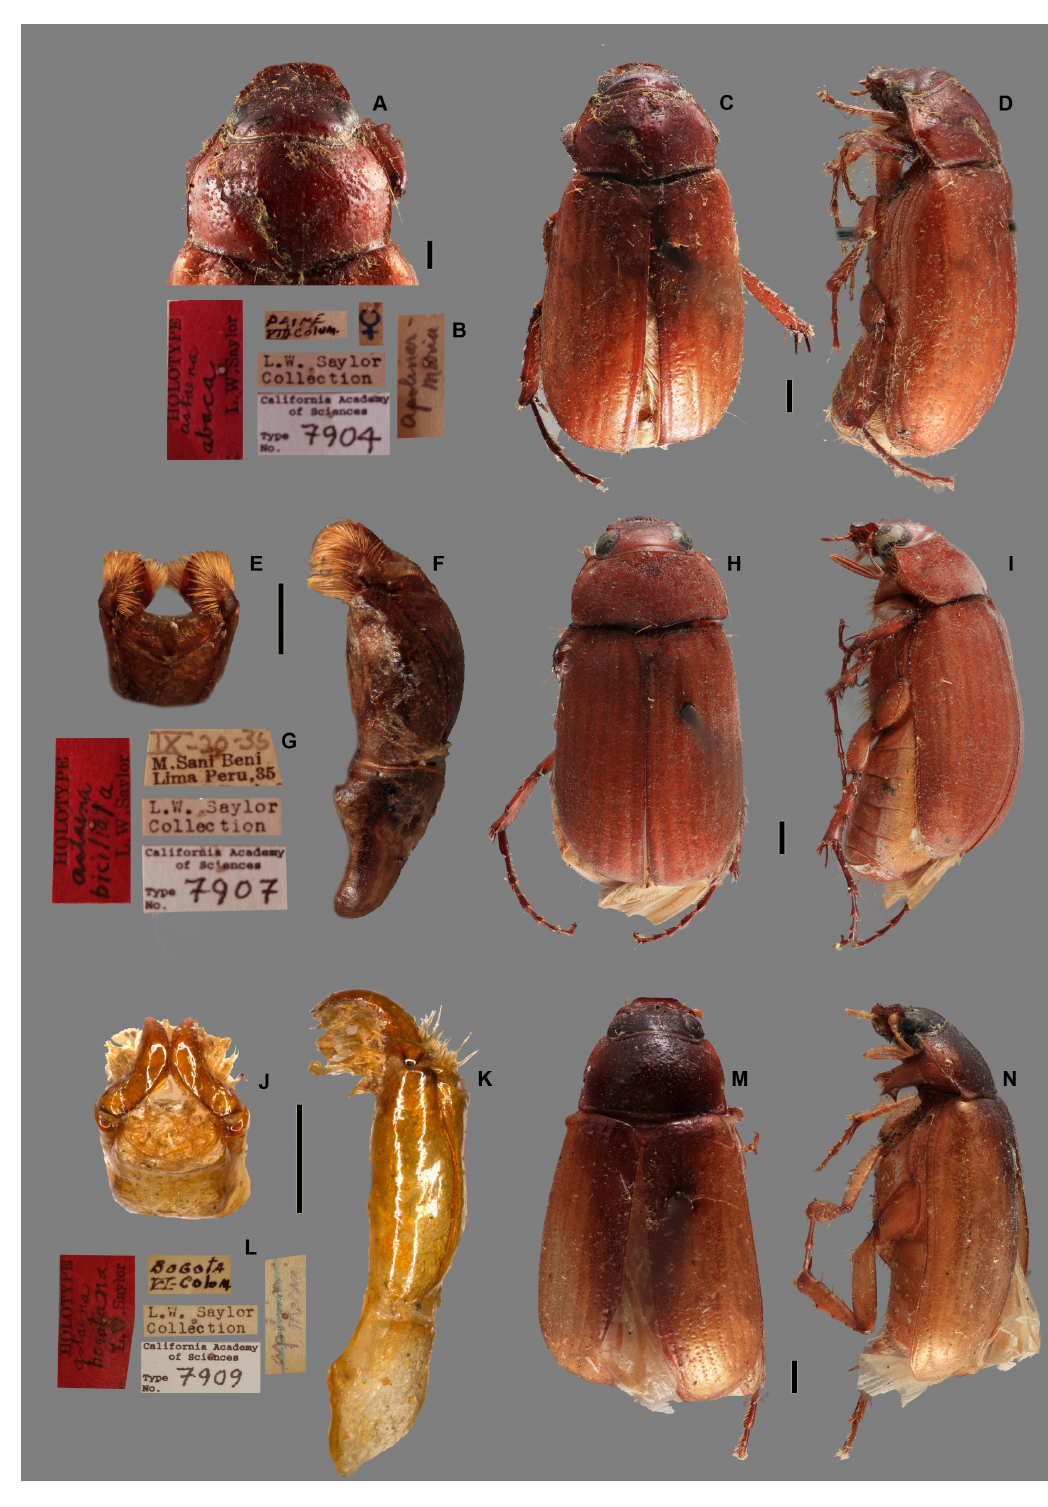
Fig. 1. A–D . Astaena abaca Saylor, 1946, holotype, ♀ (Type No. 7904; CAS). – E–I . A. biciliata Saylor, 1946, holotype, ♂ (Type No. 7907; CAS). – J–K . A. bogotana Saylor, 1946, paratype, ♂ (CAS). – L–N . A. bogotana , holotype, ♂ (Type No. 7909; CAS). A . Head and pronotum, dorsal view. B , G , L . Labels. C, H, M . Habitus, dorsal view. D, I, N . Habitus, lateral view. E, J . Parameres, dorsal view. F, K . Aedeagus, lateral view. Scale bars: A, E–F, J–K = 0.5 mm; C–D, H–I, M–N = 1